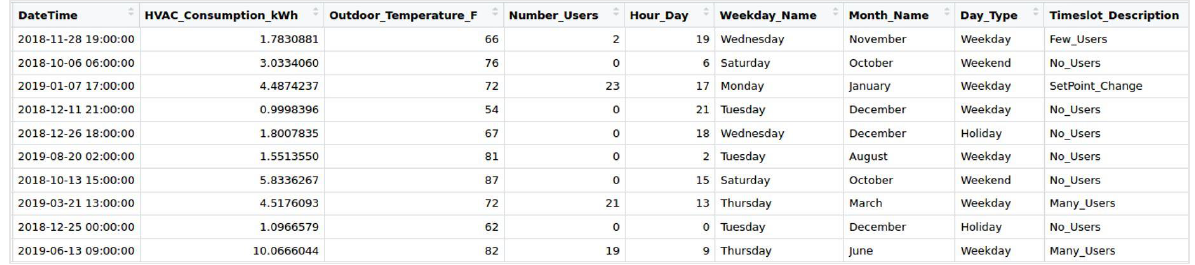
Figure 4. A sample of the HARC dataset.